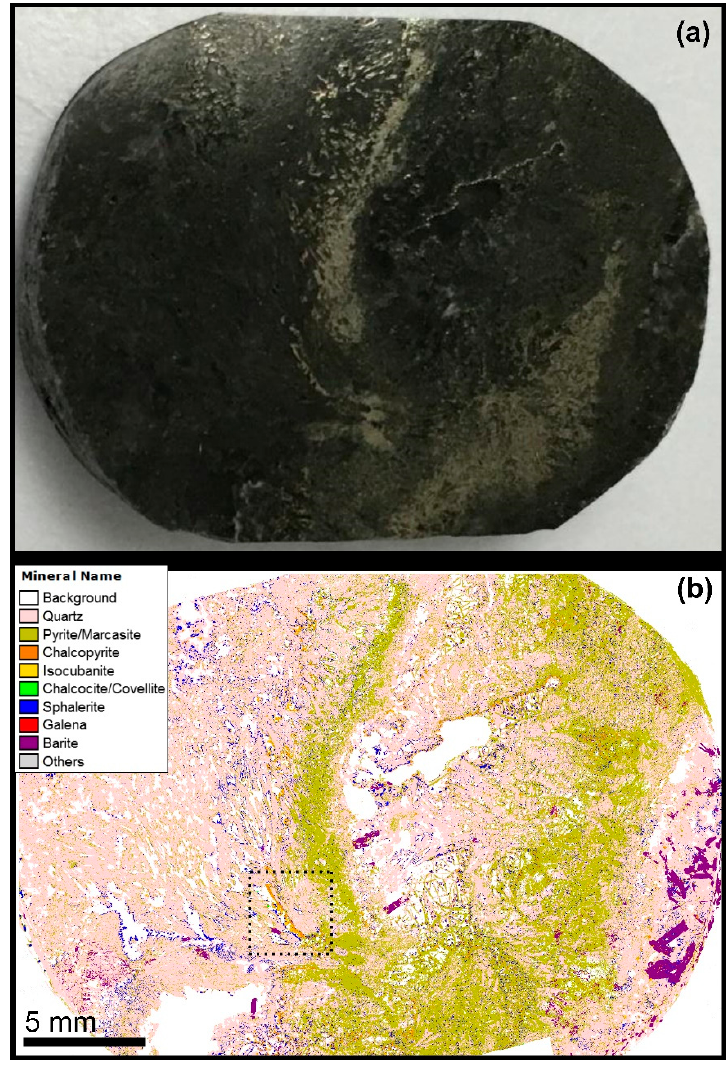
Figure 6. ( a ) Polished block of black material; ( b ) false colour QEMSCAN field scan at 10 μ m pixel spacing with the area of Figure 7a demarcated. The block was made from sample iv(b) .